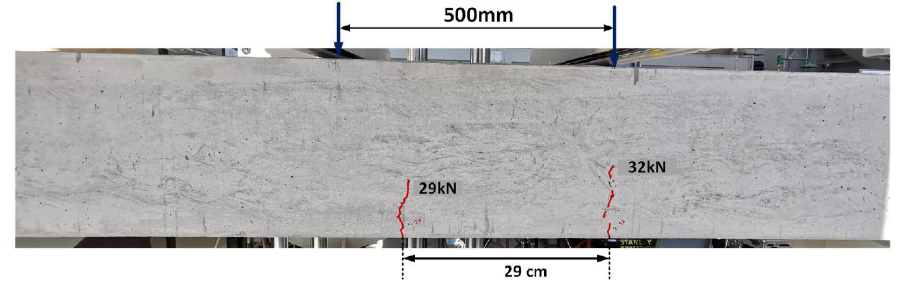
Figure 5. Crack formed in the B.30 beam (30% of Py). Beam A.50 (from Batch A) and Beam B.50 (from Batch B) were preloaded to 58 kN (50% of Py (56 kN)). The flexural cracks in Beam A.50 are shown in Figure 6a. Within the constant bending zone, three to four cracks were observed in both beams. However, two flexural-shear cracks appeared in Beam B.50. There was no significant difference between the maximum crack spacing in the A.50 and B.50 beams within the constant bending zone (see Figure 6a,b).